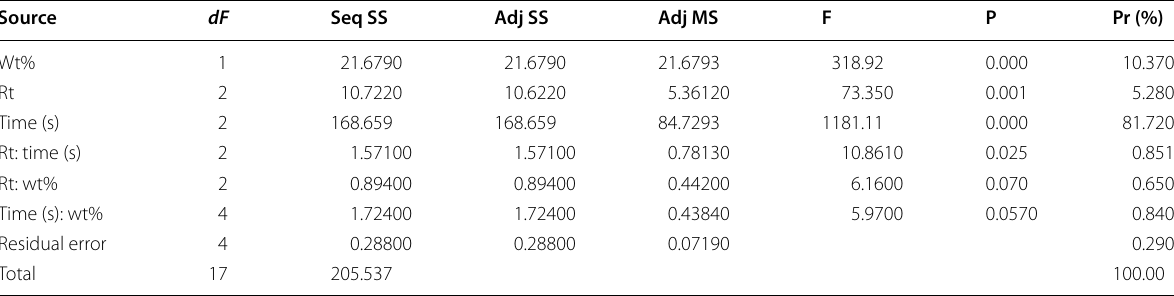
Table 8 Analysis of variance of S/N ratios for the total heat release rate